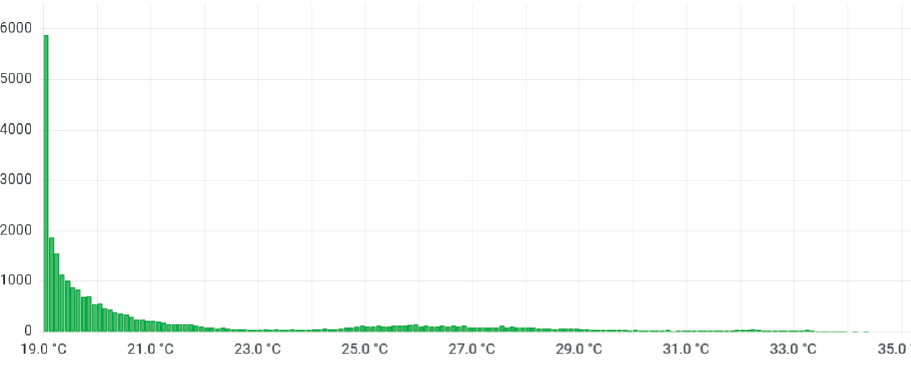
Figure 4. Indoor temperature histogram for a 2001–2010 building, when there is no penalty from too low indoor temperature.